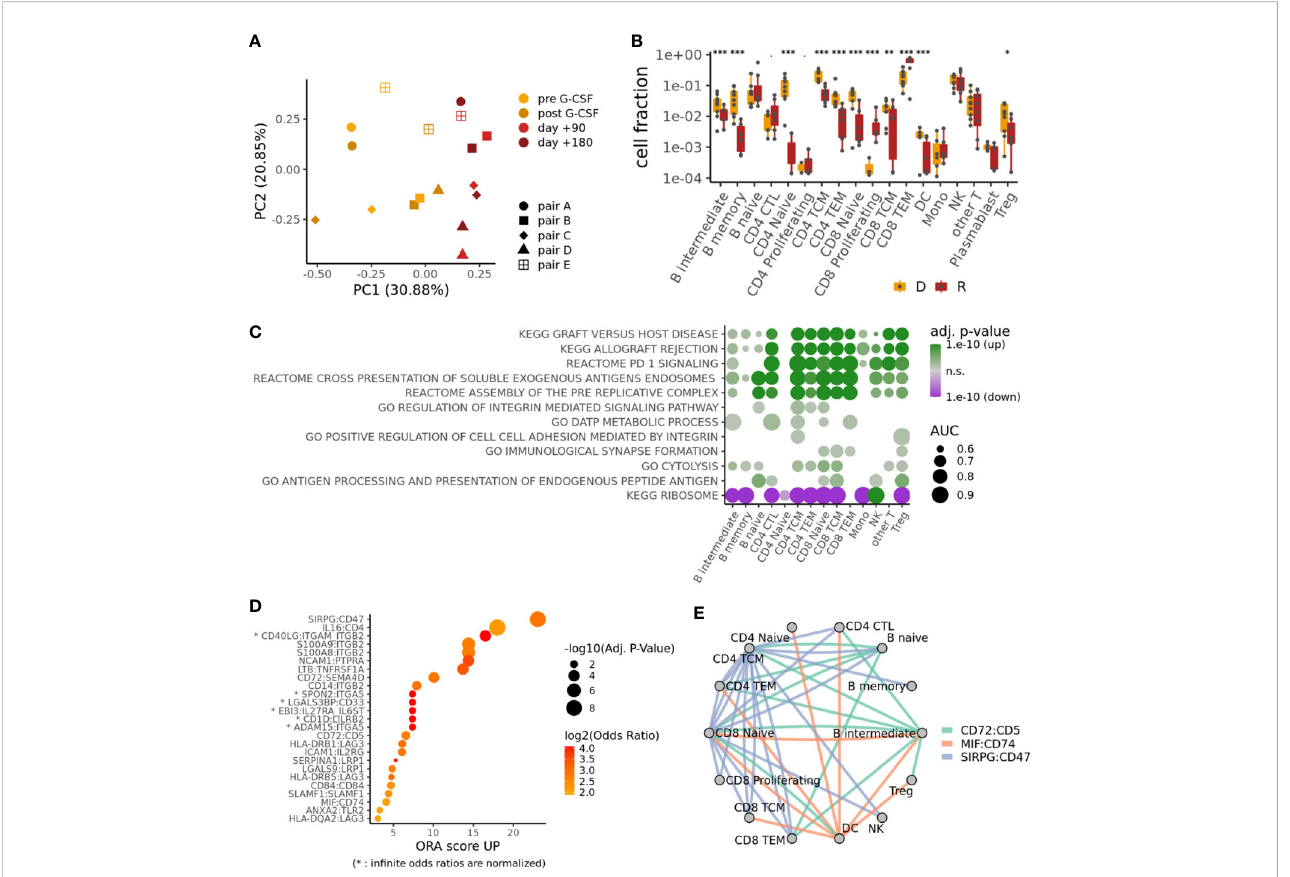
FIGURE 2 Donor-recipient shifts in cell composition, gene expression and intercellular signaling. (A) PCA on the cell type compositions of the different samples. (B) Compositional differences between samples from donors D (both pre and post G-CSF samples, if available) and recipients R (both d+90 and d+180 samples, if available). p-values from mixed-effects binomial model; ***p < 0.001, **p < 0.01, *p < 0.05. (C) Selected pathways differentially regulated between recipients and donors for each cell type; color indicates adjusted p-value and direction of change; size indicates effect size (area-under-curve). (D) Top ligand-receptor-interactions (LRIs) in an overrepresentation analysis (ORA) of differential cell-cell signaling between recipients and donors. (E) Cell-cell signaling network for top LRIs from (D)